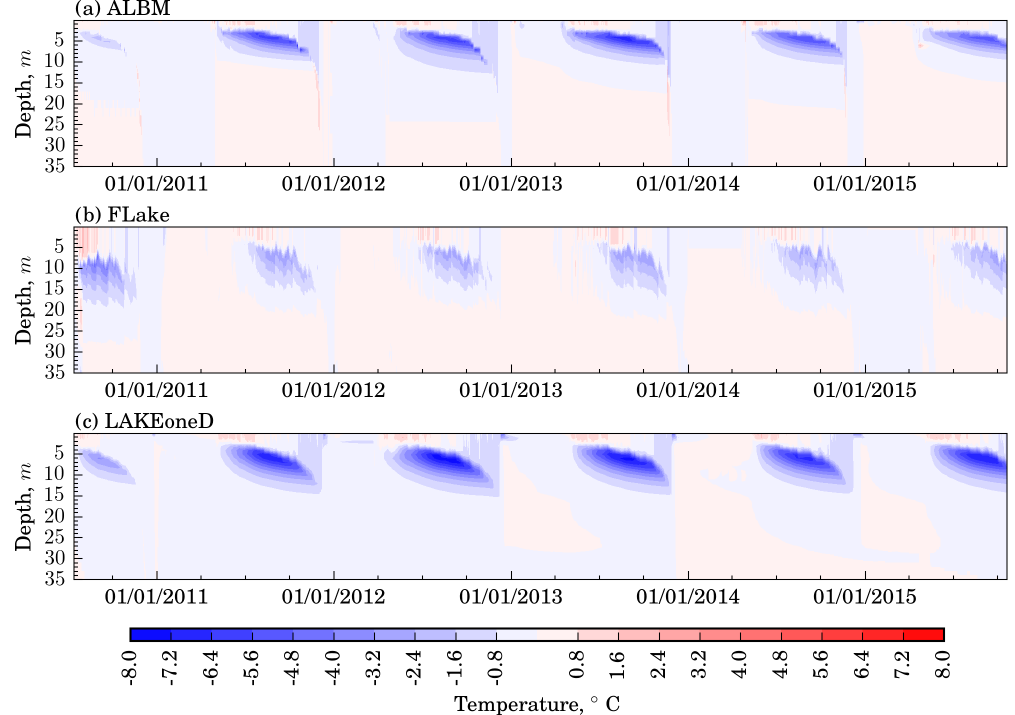
Figure 4. Temperature difference between the ExtMaxSim and RefSim experiments in three lake models: (a) ALBM; (b) FLake; (c)